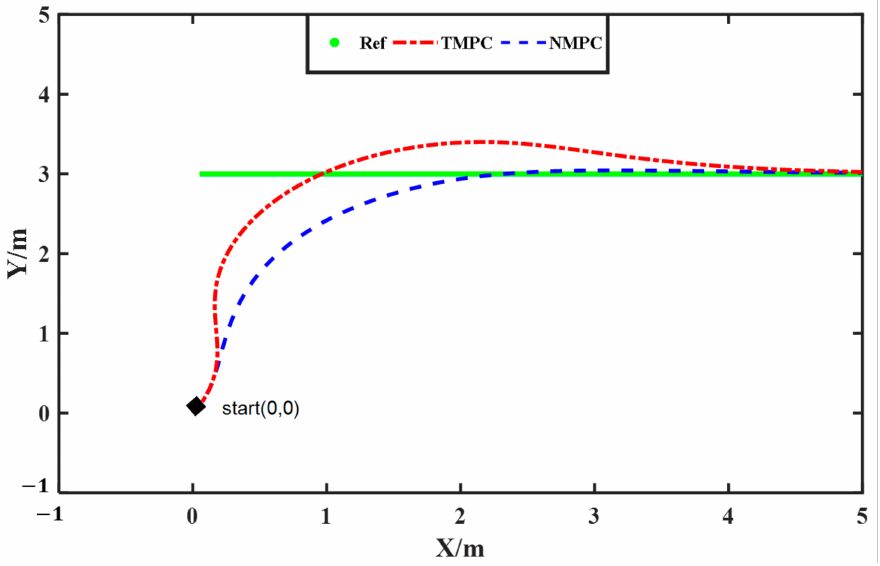
Figure 3. The simulation tracking results under the